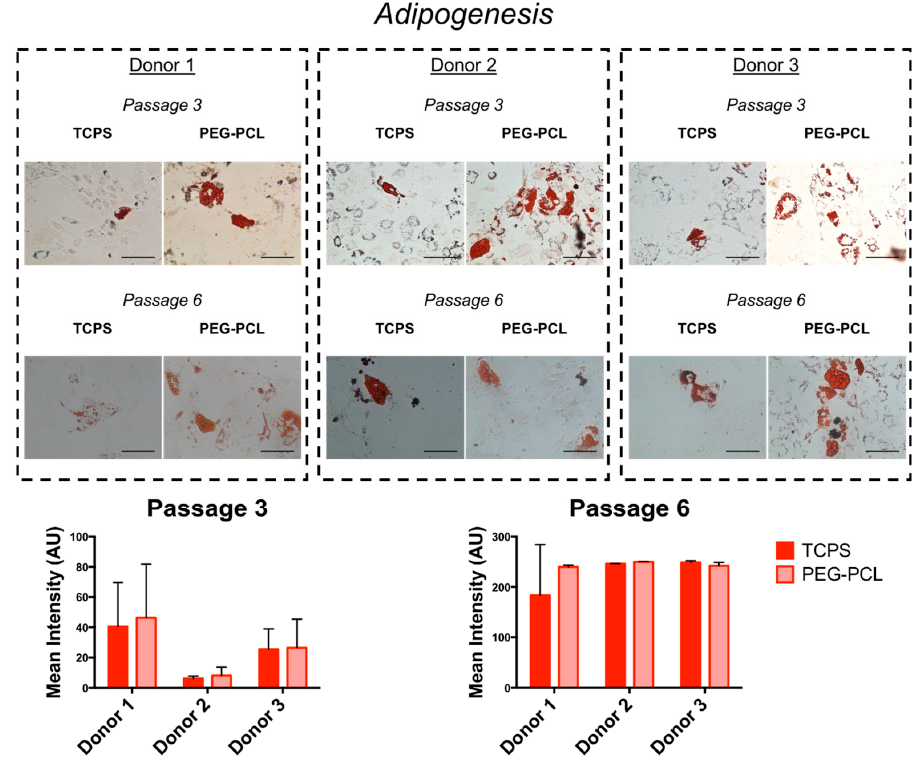
Figure 5. Adipogenic differentiation of hMSCs. hMSCs were stained with Oil Red O after one month of adipogenic differentiation. Oil Red O staining did not appear different across all donors for both passages, and heterogeneity of droplet size can be seen in the images. Mean intensity of the stain is plotted for all donors for each substrate with n = 3 independent experimental replicates, and no significant differences between TCPS and PEG-PCL were reported. Scale bar = 100 μ m.